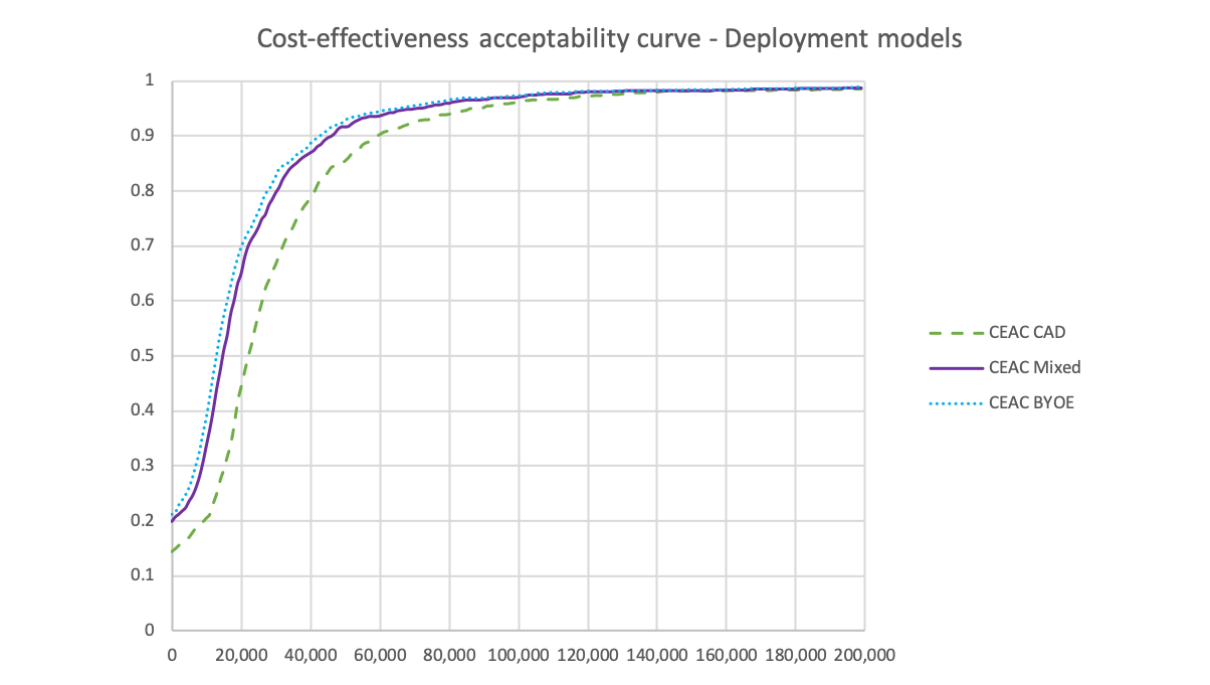
Figure 6. Cost-effectiveness acceptability curves for each deployment model in the scenario analyses. BYOE: Bring Your Own Everything; CEAC: cost-effectiveness acceptability curve; FK: Full